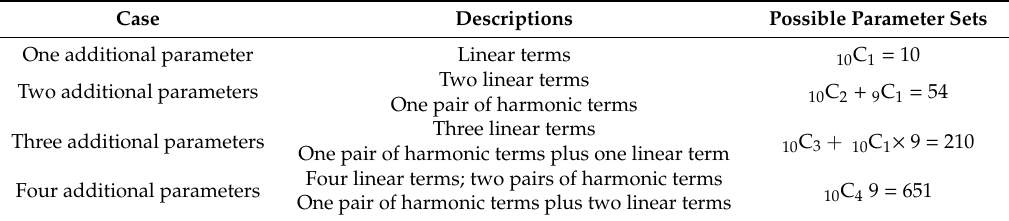
Table 3. The number of possible parameter sets according to the number of additional